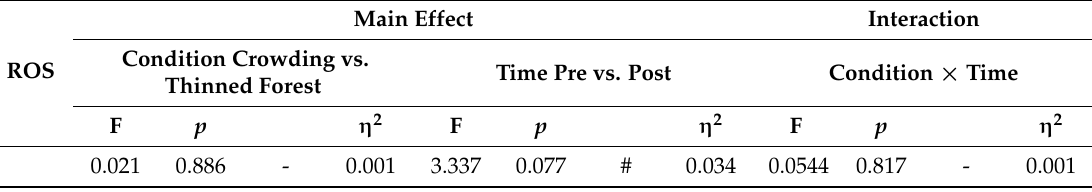
Table 11. Results for the two-way repeated-measures ANOVAs for the ROS scores. Main Effect Interaction Condition Crowding vs. ROS Time Pre vs. Post Condition × Time Thinned Forest